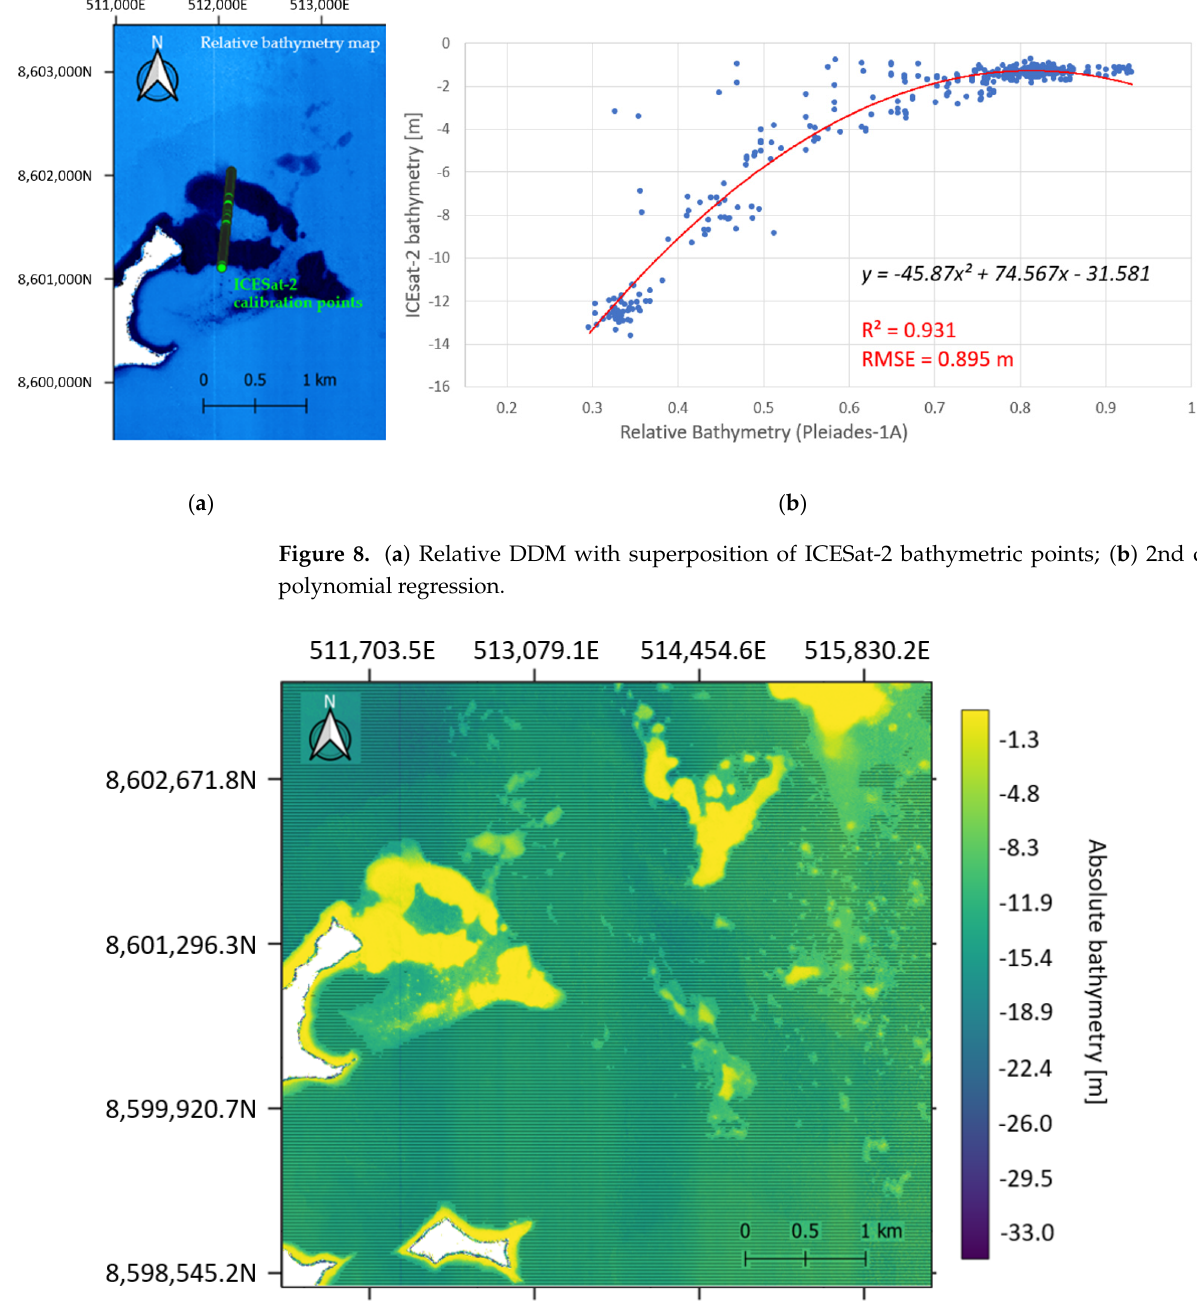
Figure 9. Digital depth model at the acquisition time of Pleiades-1A, calibrated with the ICESat-2